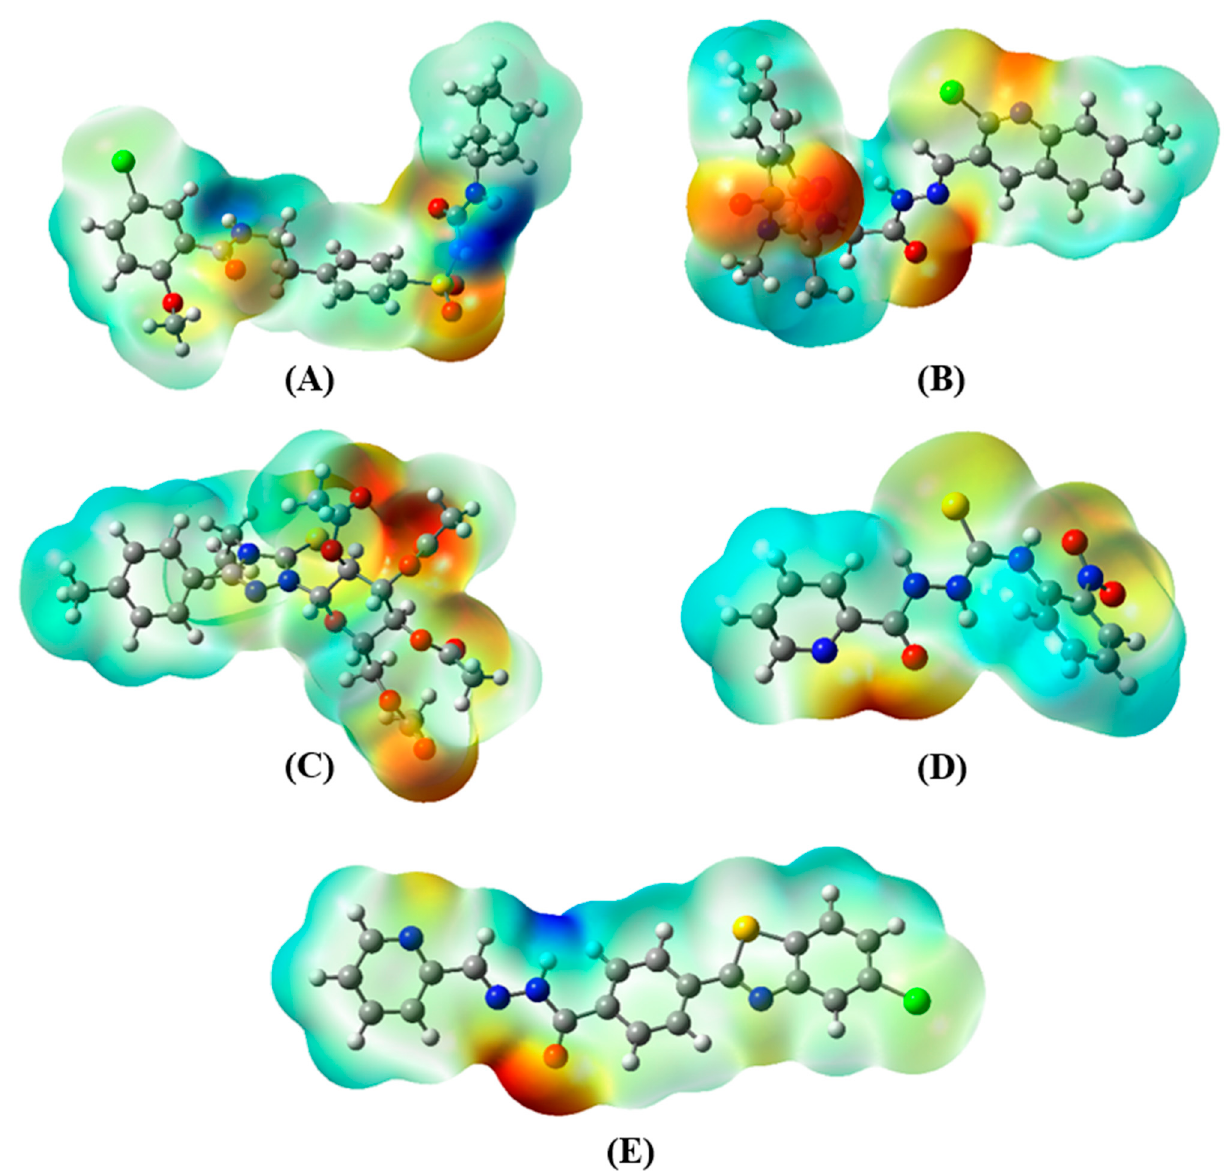
Figure 4. Electrostatic potential maps for ( A ) AKS-01, ( B ) AKS-02, ( C ) AKS-03, ( D ) AKS-04, and ( E ) AKS-05.